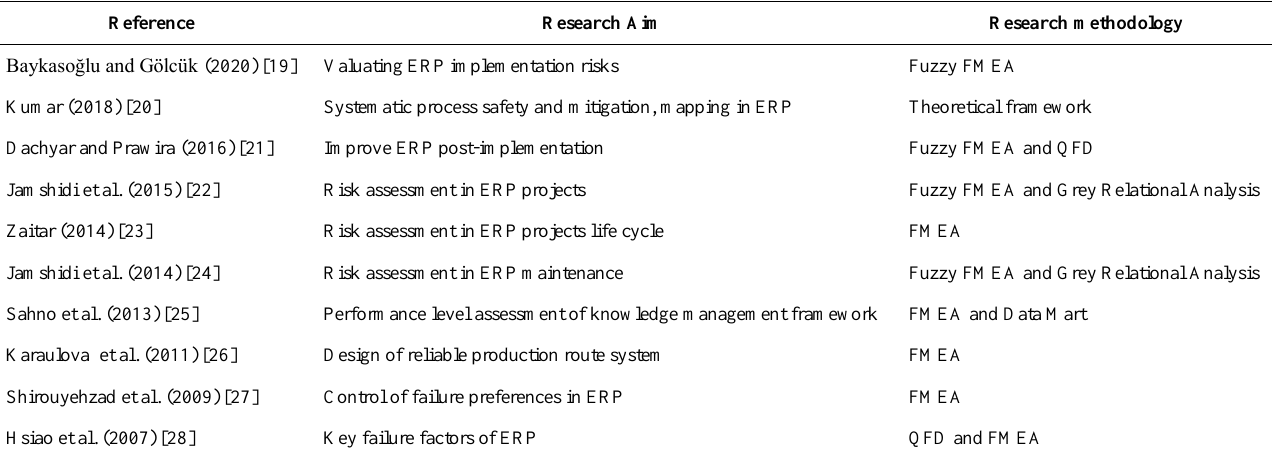
Table 1. Summary of literature review